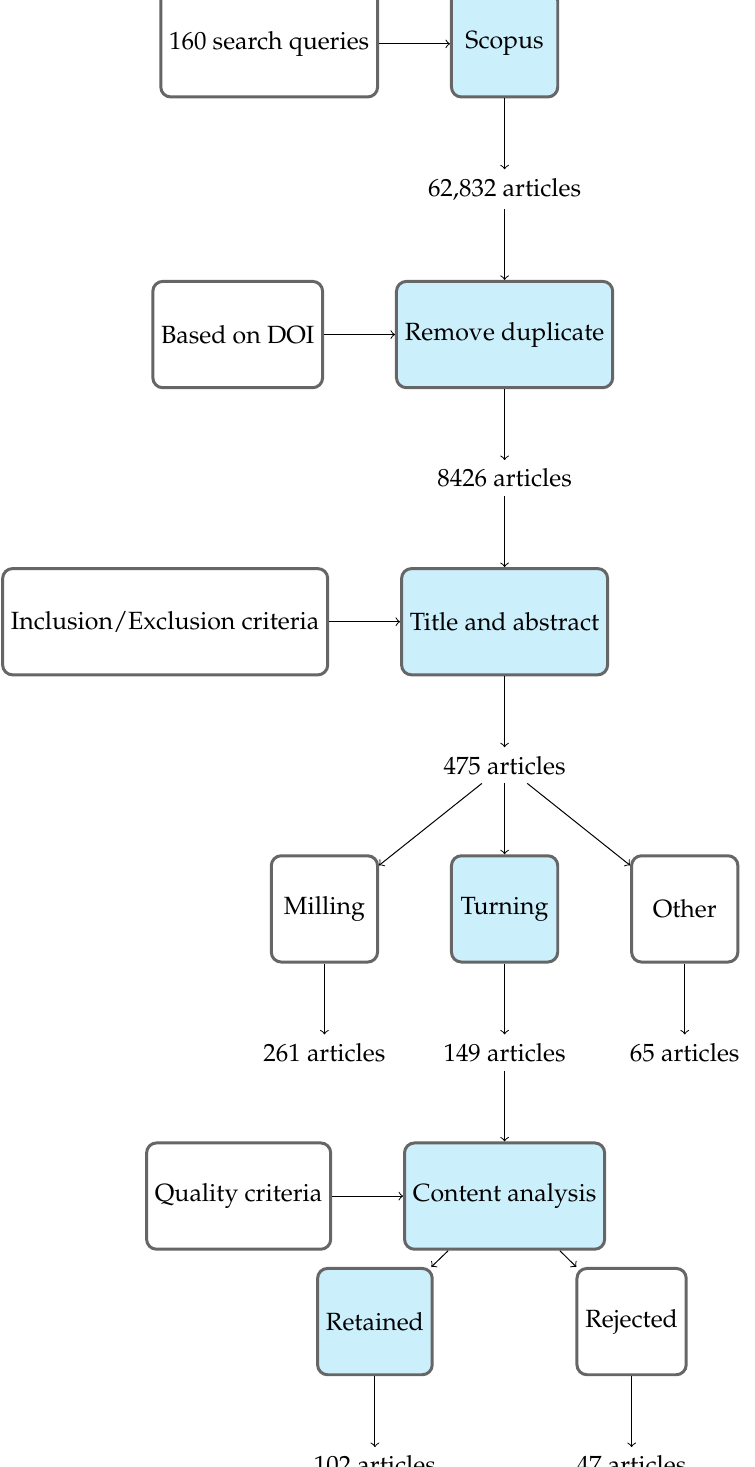
Figure 3. Methodology pursued to identify the 102